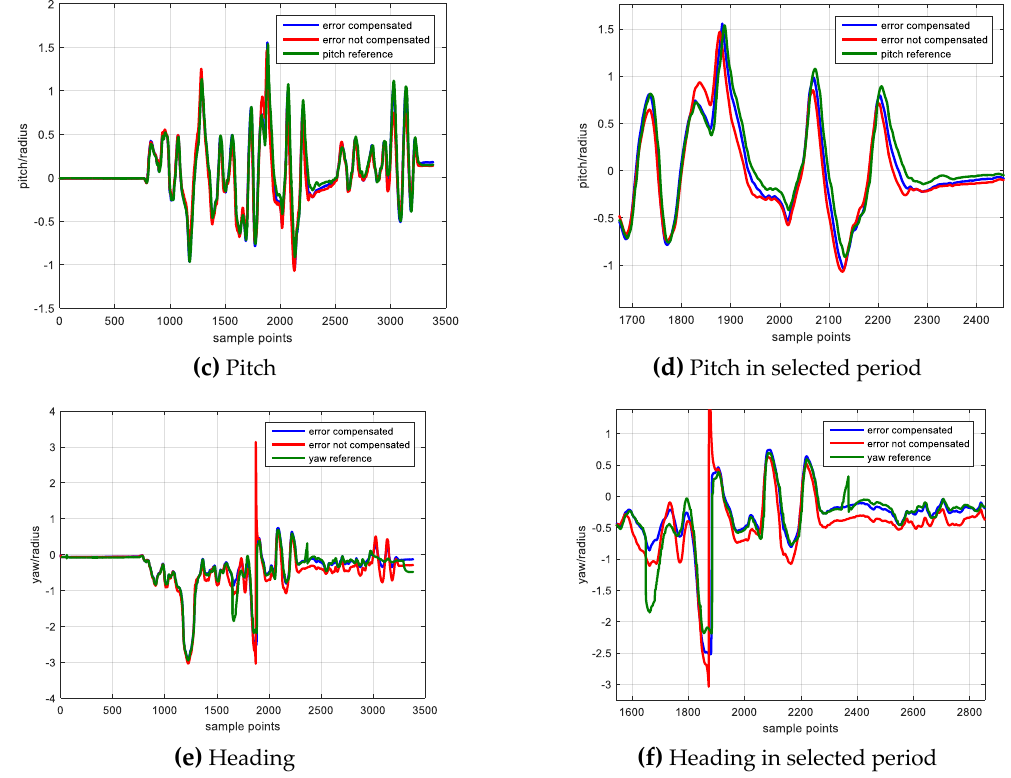
Figure 7. Comparison of Attitude Result.